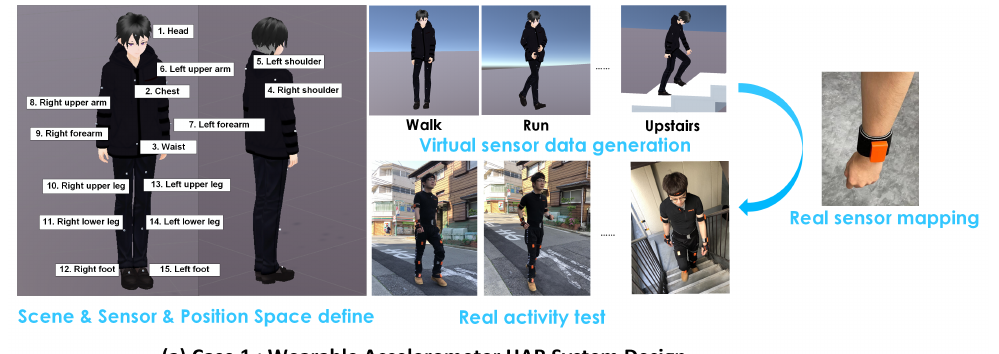
Figure 8. Case 1: Wearable accelerometer study; 15 sensor position spaces are found, 5 activities are